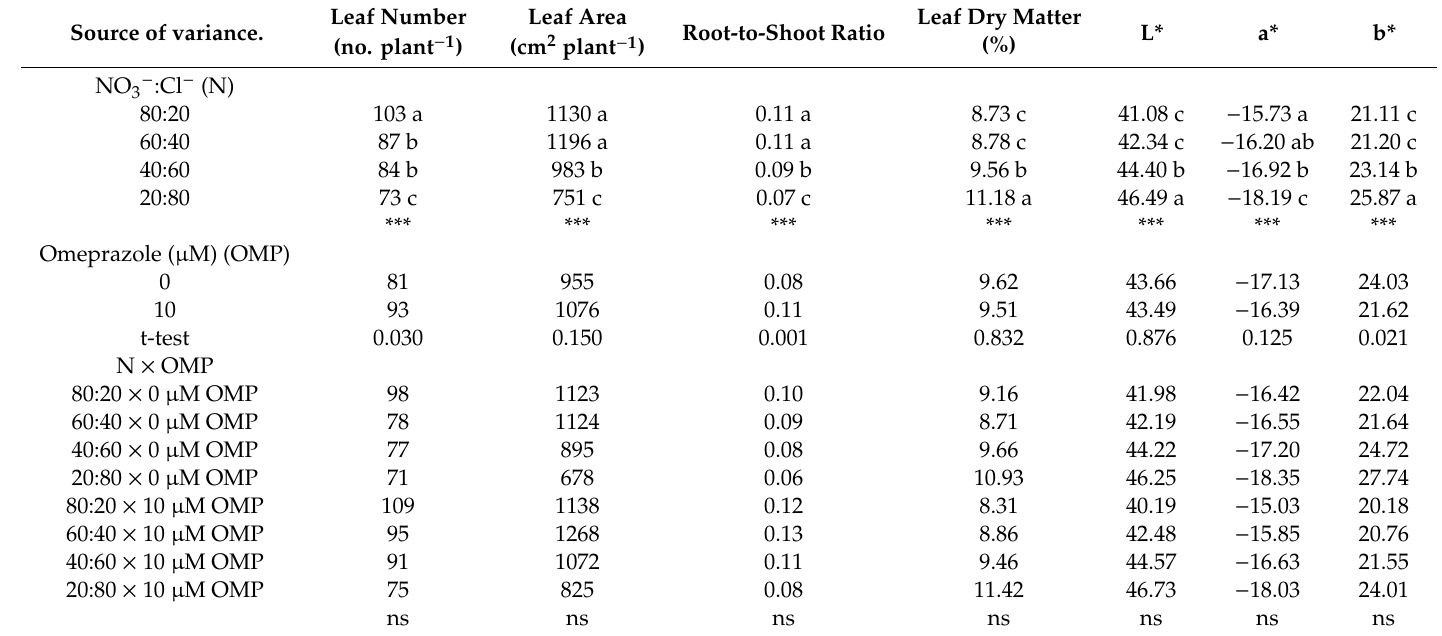
Table 1. E ff ects NO 3 − :Cl − ratio in the nutrient solution and omeprazole (OMP) application rates on growth parameters, root-to-shoot ratio and leaf colorimetry of greenhouse hydroponic basil